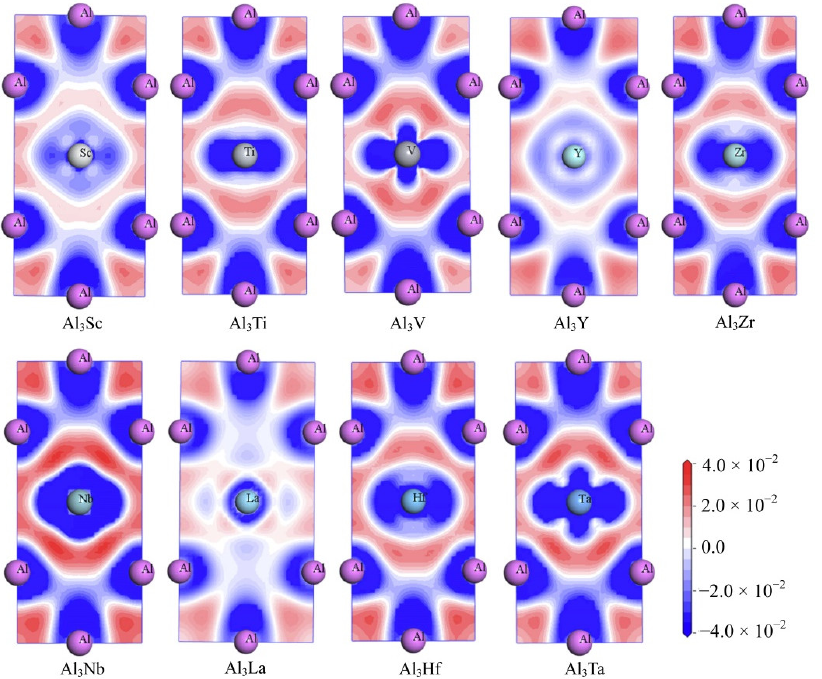
Figure 10. The electron density difference of Al 3 TM compounds.